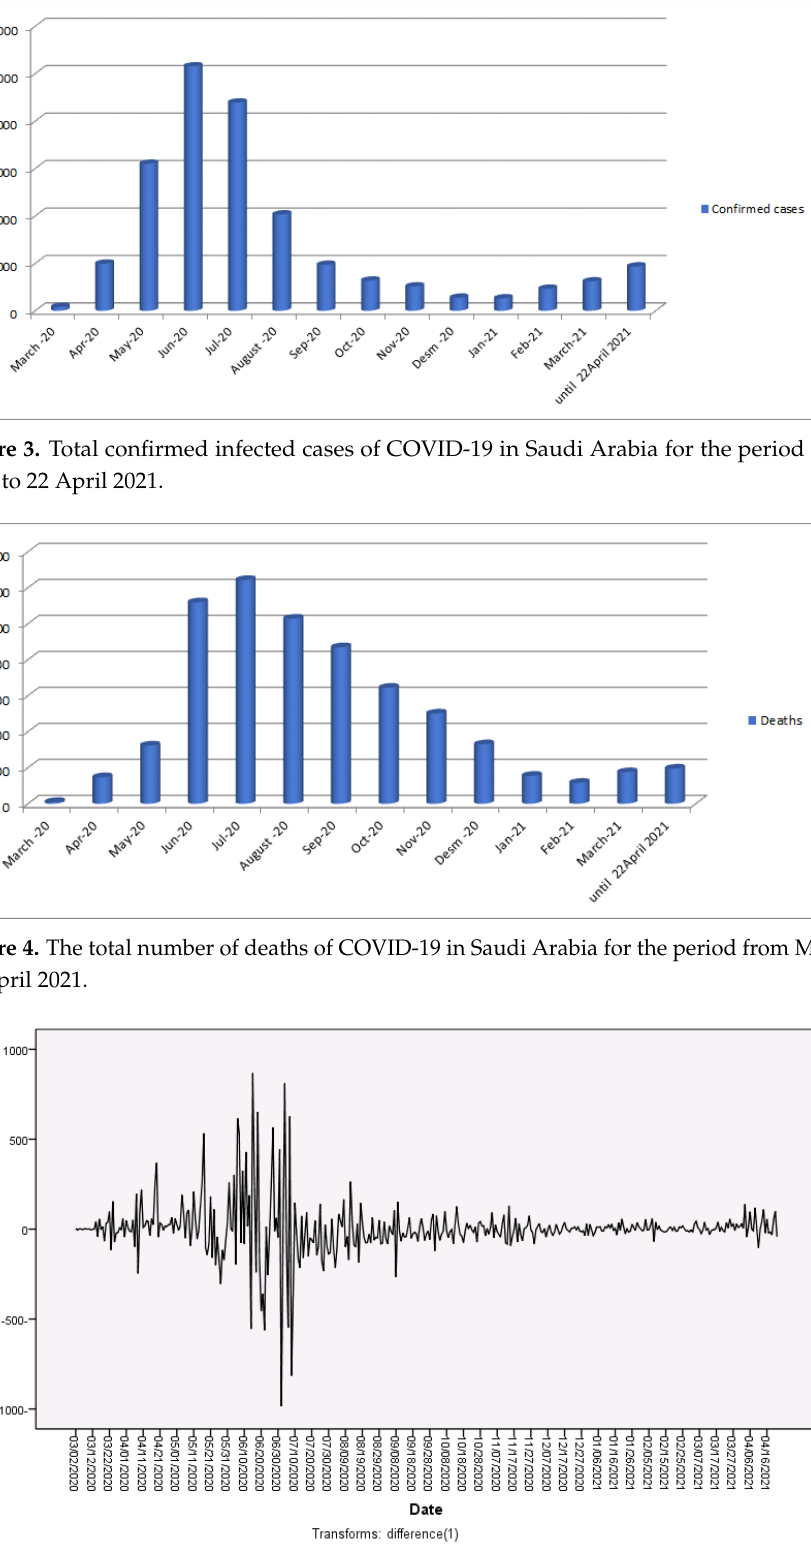
Figure 5. Transmission of the data of confirmed cases of COVID-19 in Saudi Arabia to the first